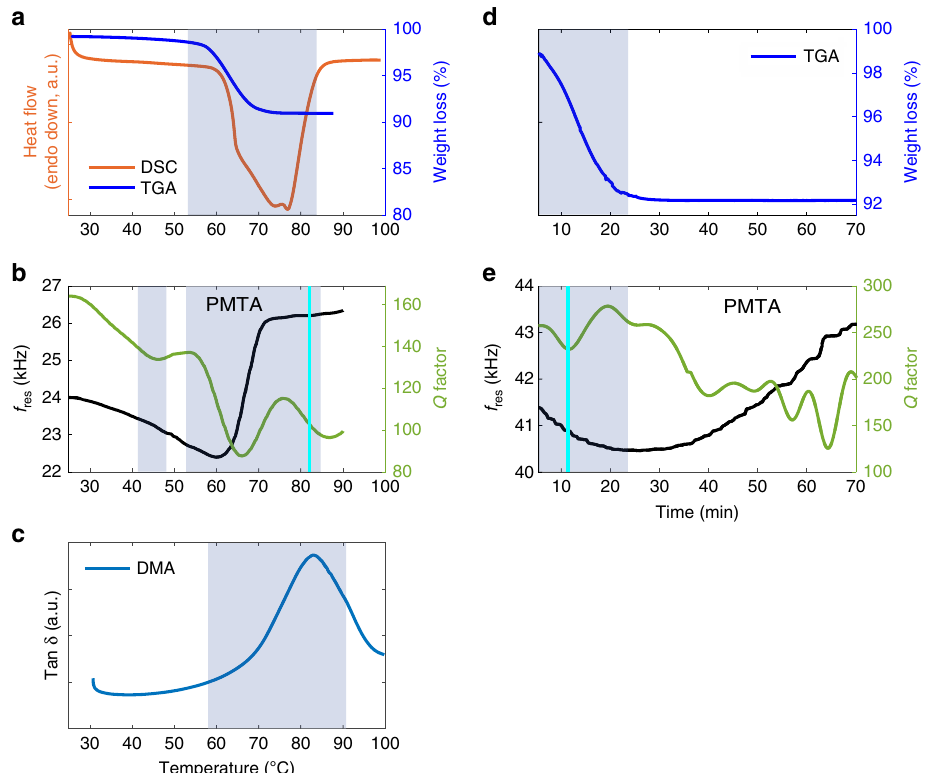
Fig. 3 Comparison of standard thermal methods to PMTA. a DSC and TGA thermograms of ∼ 9 mg of TP MH showing water loss at 58 – 85 °C (5 °C/min), b tracked f res and Q of a single particle (1200 μ m × 85 μ m) of TP MH (5 °C/min), c DMA thermogram of ∼ 50 – 100 mg TP MH at 5 °C/min, d isothermal TGA thermogram of TP MH ( ∼ 10 mg) at 50 °C for 70 min, e tracked f res and Q during isothermal dehydration of a TP MH resonator (1600 μ m × 66 μ m) of TP MH at 50 °C for 70 min. The shaded regions in the fi gures highlight the main dehydration transitions of TP